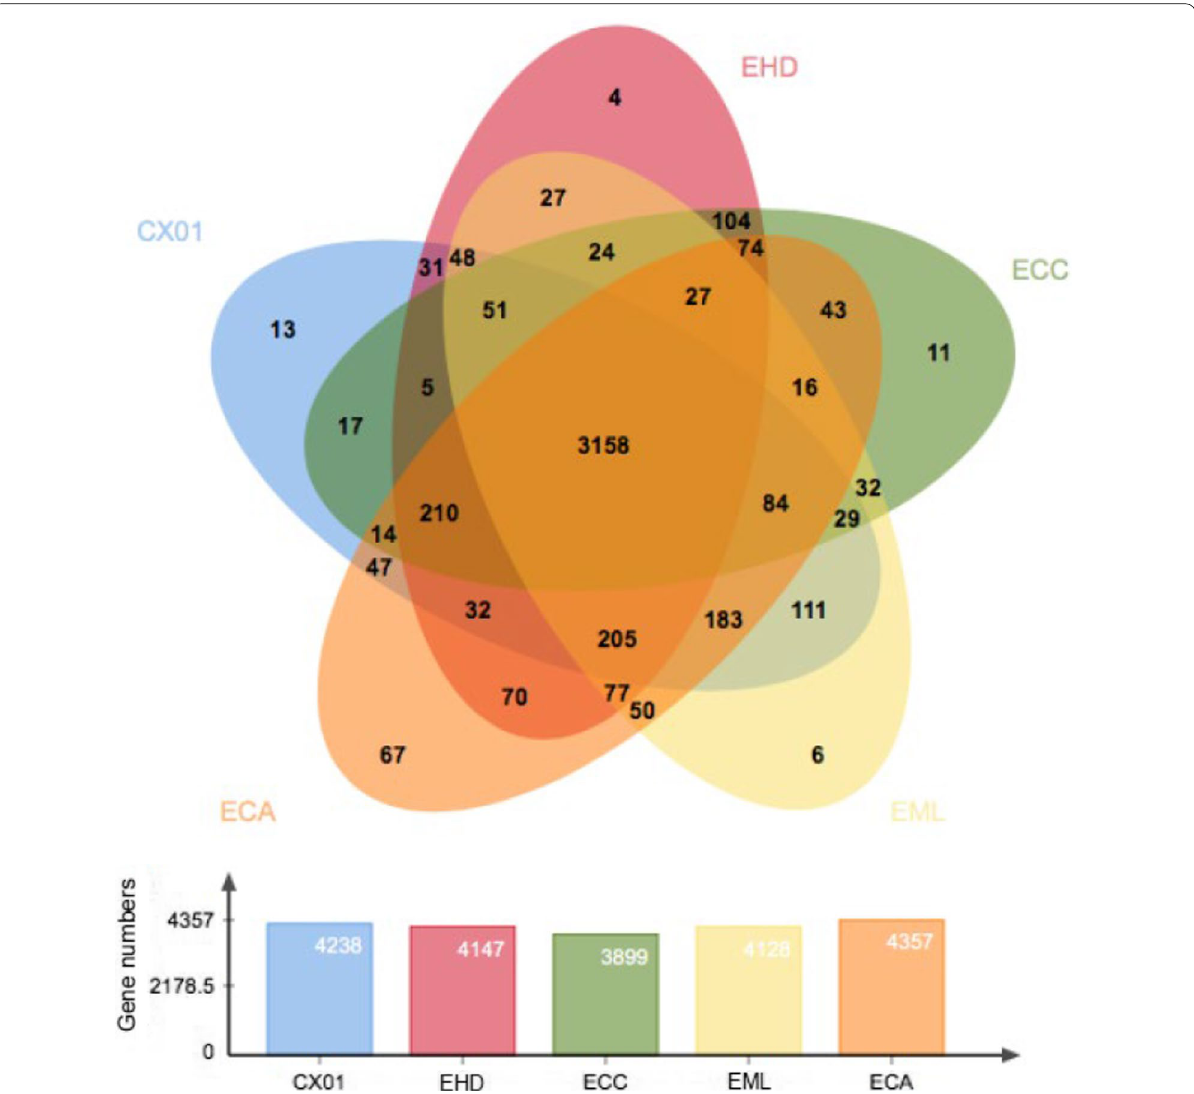
Fig. 4 Comparison of COGs in five Enterobacter species. The numbers in overlapped regions of Venn diagram represent CDS numbers shared by the genomes, including E. mori LMG 25706 (EML), E. mori CX01 (CX01, CP055276), E. cloacae ATCC 13047 (ECA, NC_014121.1), E. hormaechei DSM 16691 (EHD, NZ_CP017179.1) and E. cancerogenus CR-Eb1 (ECC,